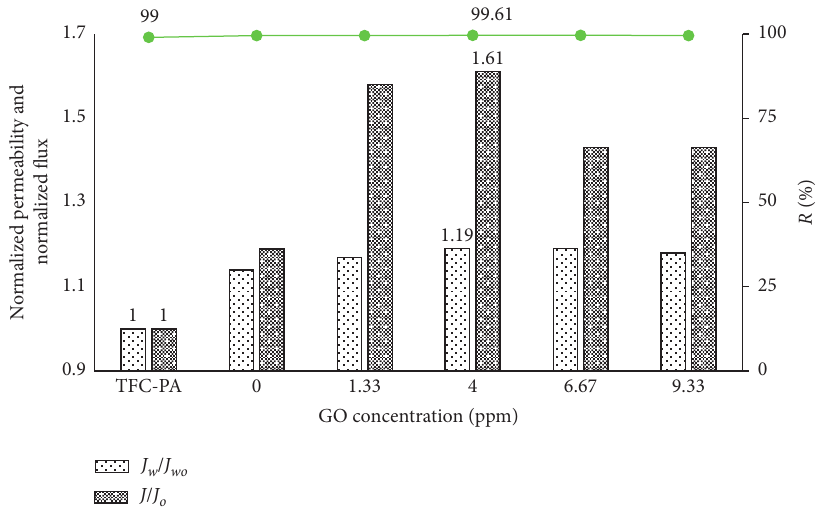
Figure 7: Normalized permeability and normalized flux of the uncoated and GO-TiO